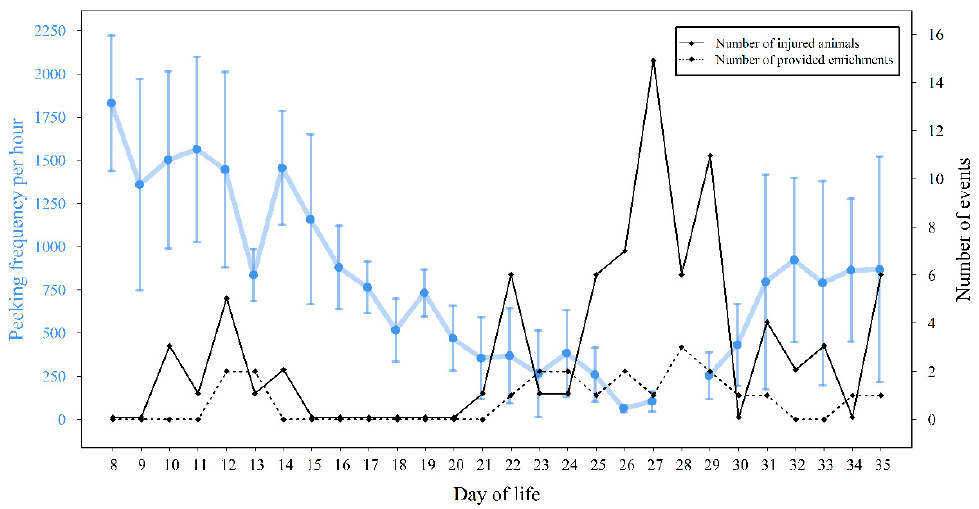
Figure 3. Mean values and standard deviations of pecking frequencies per hour (blue) for life day 8– 35 on farm 1 ( n = 12 h, day 28: missing value), number of injured animals (black) separated and the ff ered from day 8 to 35 of number of various enrichments offered from day 8 to 35 of life. number of various enrichments o